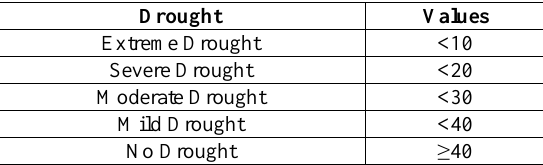
Table 1: classification of VCI, VHI, TCI values for drought